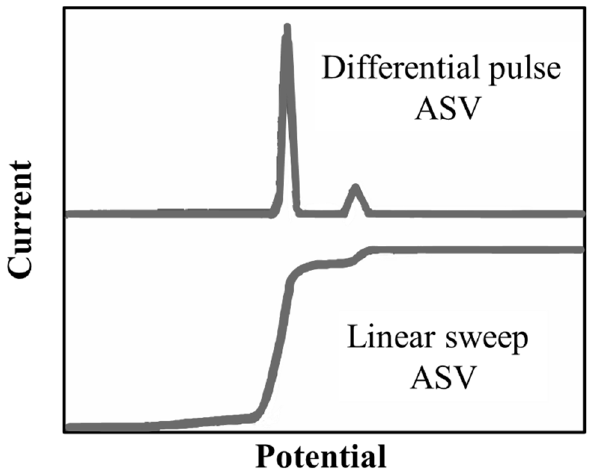
Figure 5. Profile of the current versus the potential for the linear sweep and differential pulse voltammograms in the presence of two contaminants.